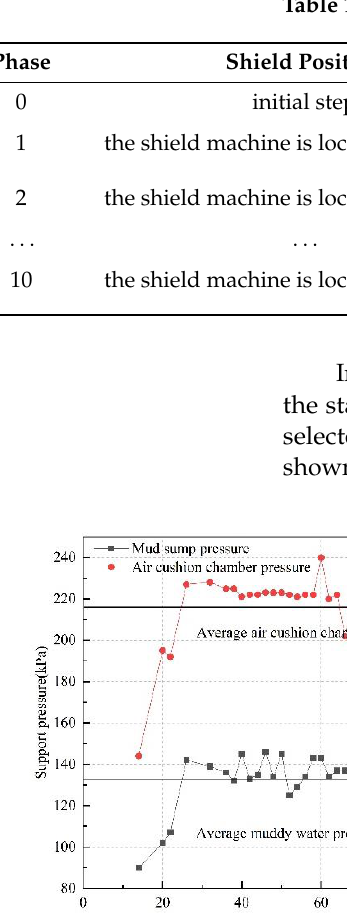
Table 1. Tunnel excavation condition setting.